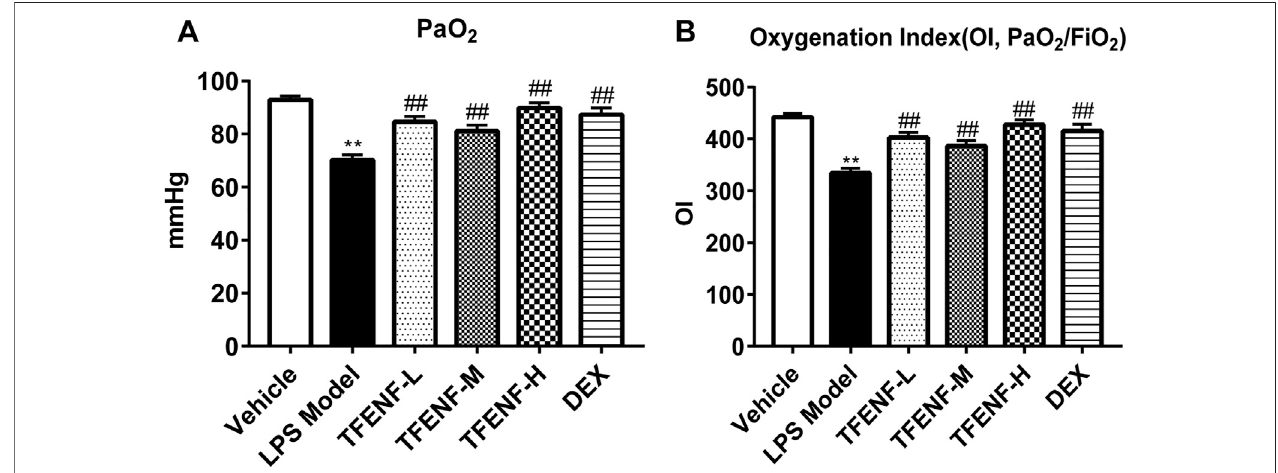
FIGURE3| TFENF ameliorated PaO 2 and IOofarterialblood gasanalysis inLPS-induced ALI. Rat arterial blood gasanalysisto determine PaO 2 (A) and IO (B) 6 h after LPS-induced ALI or saline treatment ( n (cid:2) 6 per group). Dataare presented as mean ± S.E.M. ** p < 0.01compared with the vehicle group; # p < 0.05 compared with the LPS model group; ## p < 0.01 compared with the LPS model group.